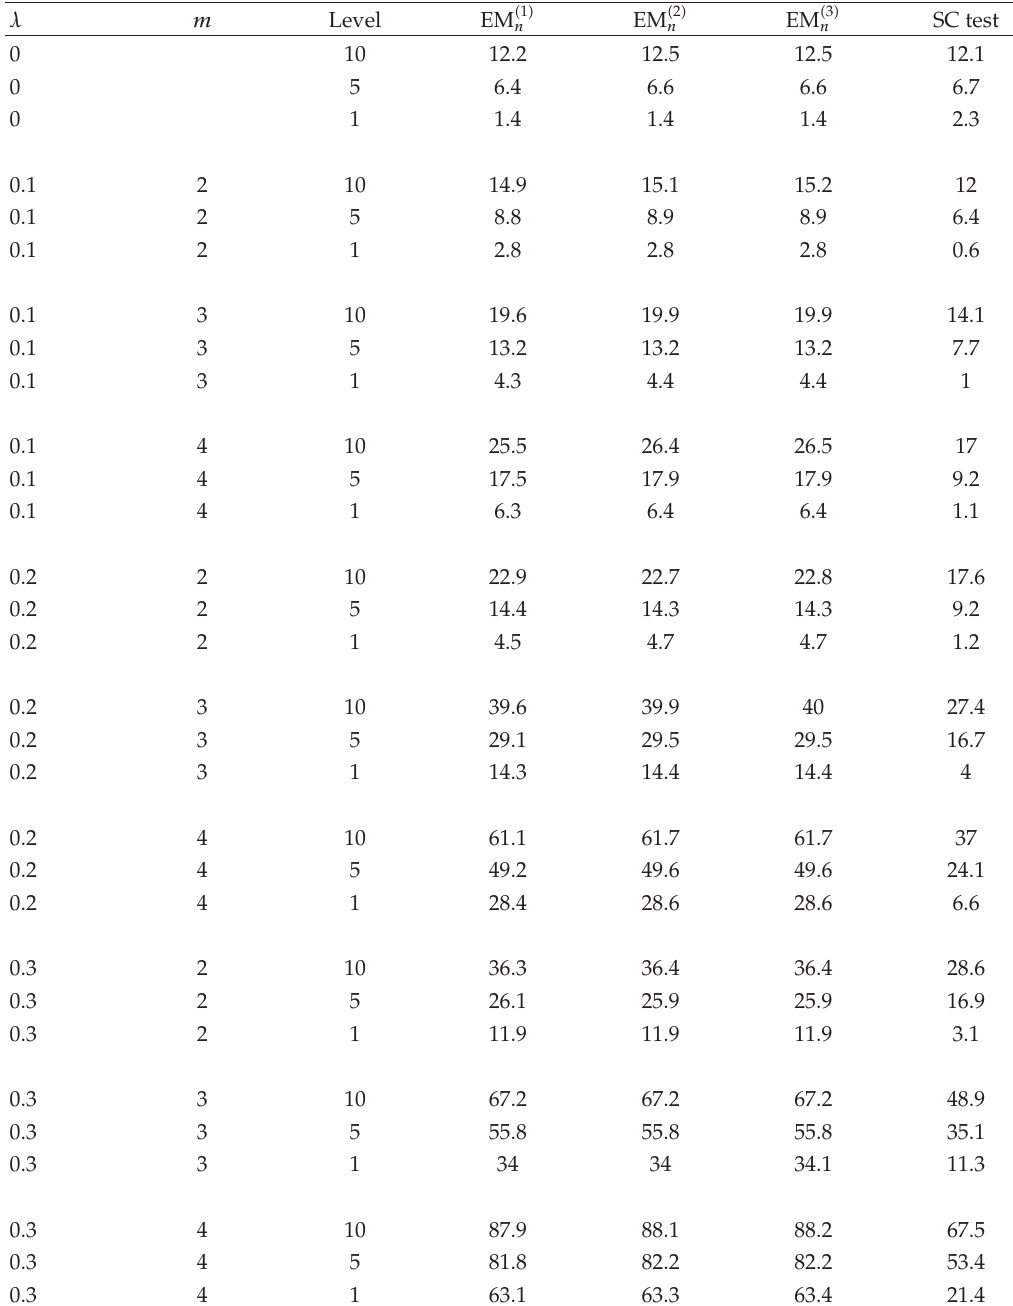
Table 3: Type I error and power comparisons (cid:2) % (cid:3) of the EM test and the score test (cid:2) SC test (cid:3) for gamma model: n 0 (cid:5) n 1 (cid:5)